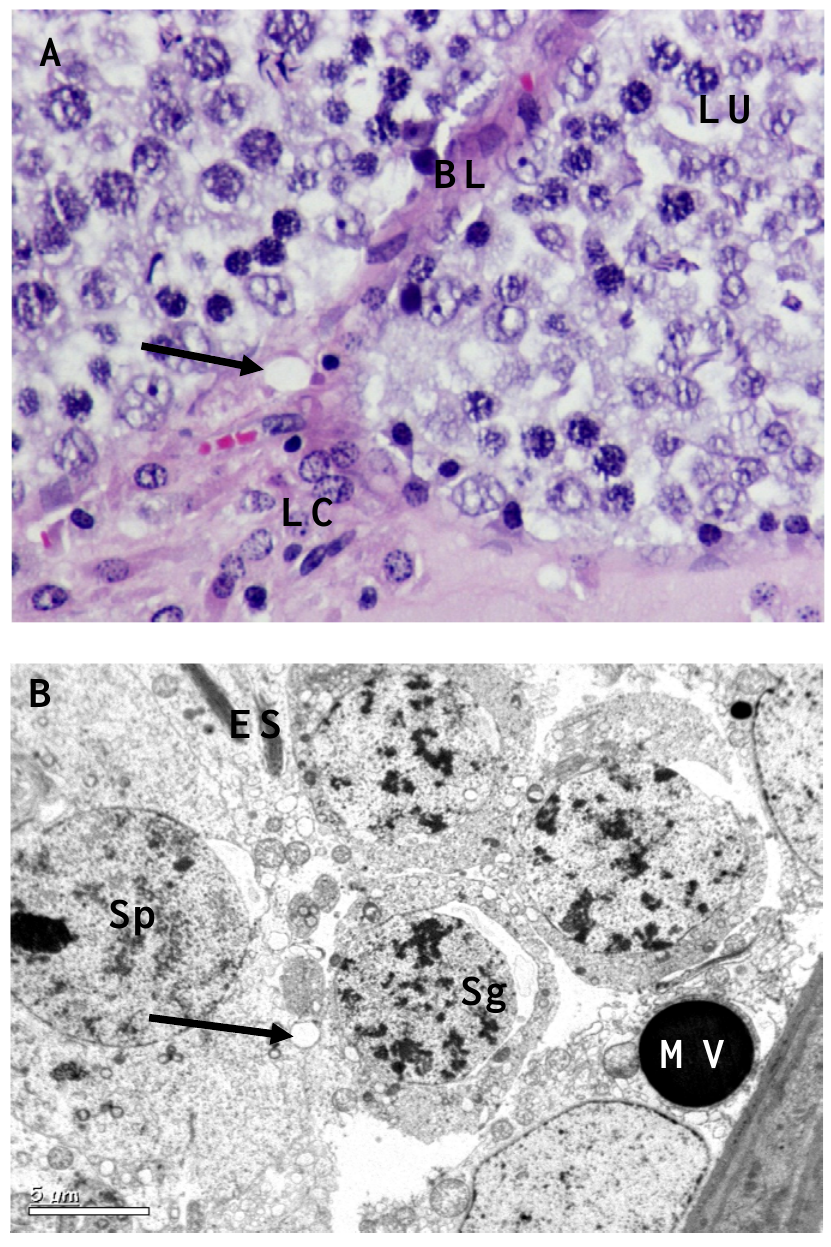
Figure 2. Testis of B. papyrifera smoke exposed rat. ( A ) Seminiferous tubules of the rat exposed to B. papyrifera exhibiting extensive damage on tubules and reduction in size. Disruption of seminiferous epithelium was evident. Spermatogenesis stopped at the primary spermatocytes stage. Interstitial spaces increased and atrophy of Leydig cells (LC); which are sparsely distributed. The germ cells showed overall decrease in cytoplasmic ground substance followed by vacuolization (arrow) at the basal lamina (BL) and towards the lumen (LU) × 1,000. ( B ) There was a complete disturbance in the spermatogonia (Sg) and spermatids (Sp). Disturbed elongated spermatids were seen at one corner (ES). Lysosome (arrow) like bodies was evident in the section. Vacuolization throughout the cytoplasm, cell debris and disturbed cell organelles were evident. A large micro vesicle (MV) was seen at the basal lamina